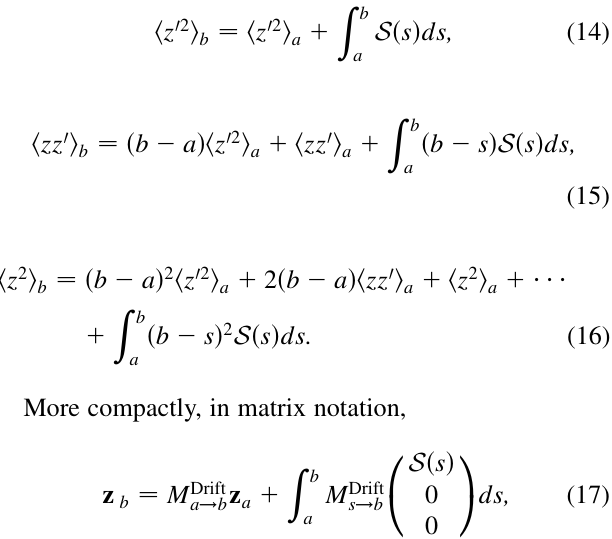
and h z 2 i for an initial beam z a that is scattered along a drift space, as indicated in Fig. 3: